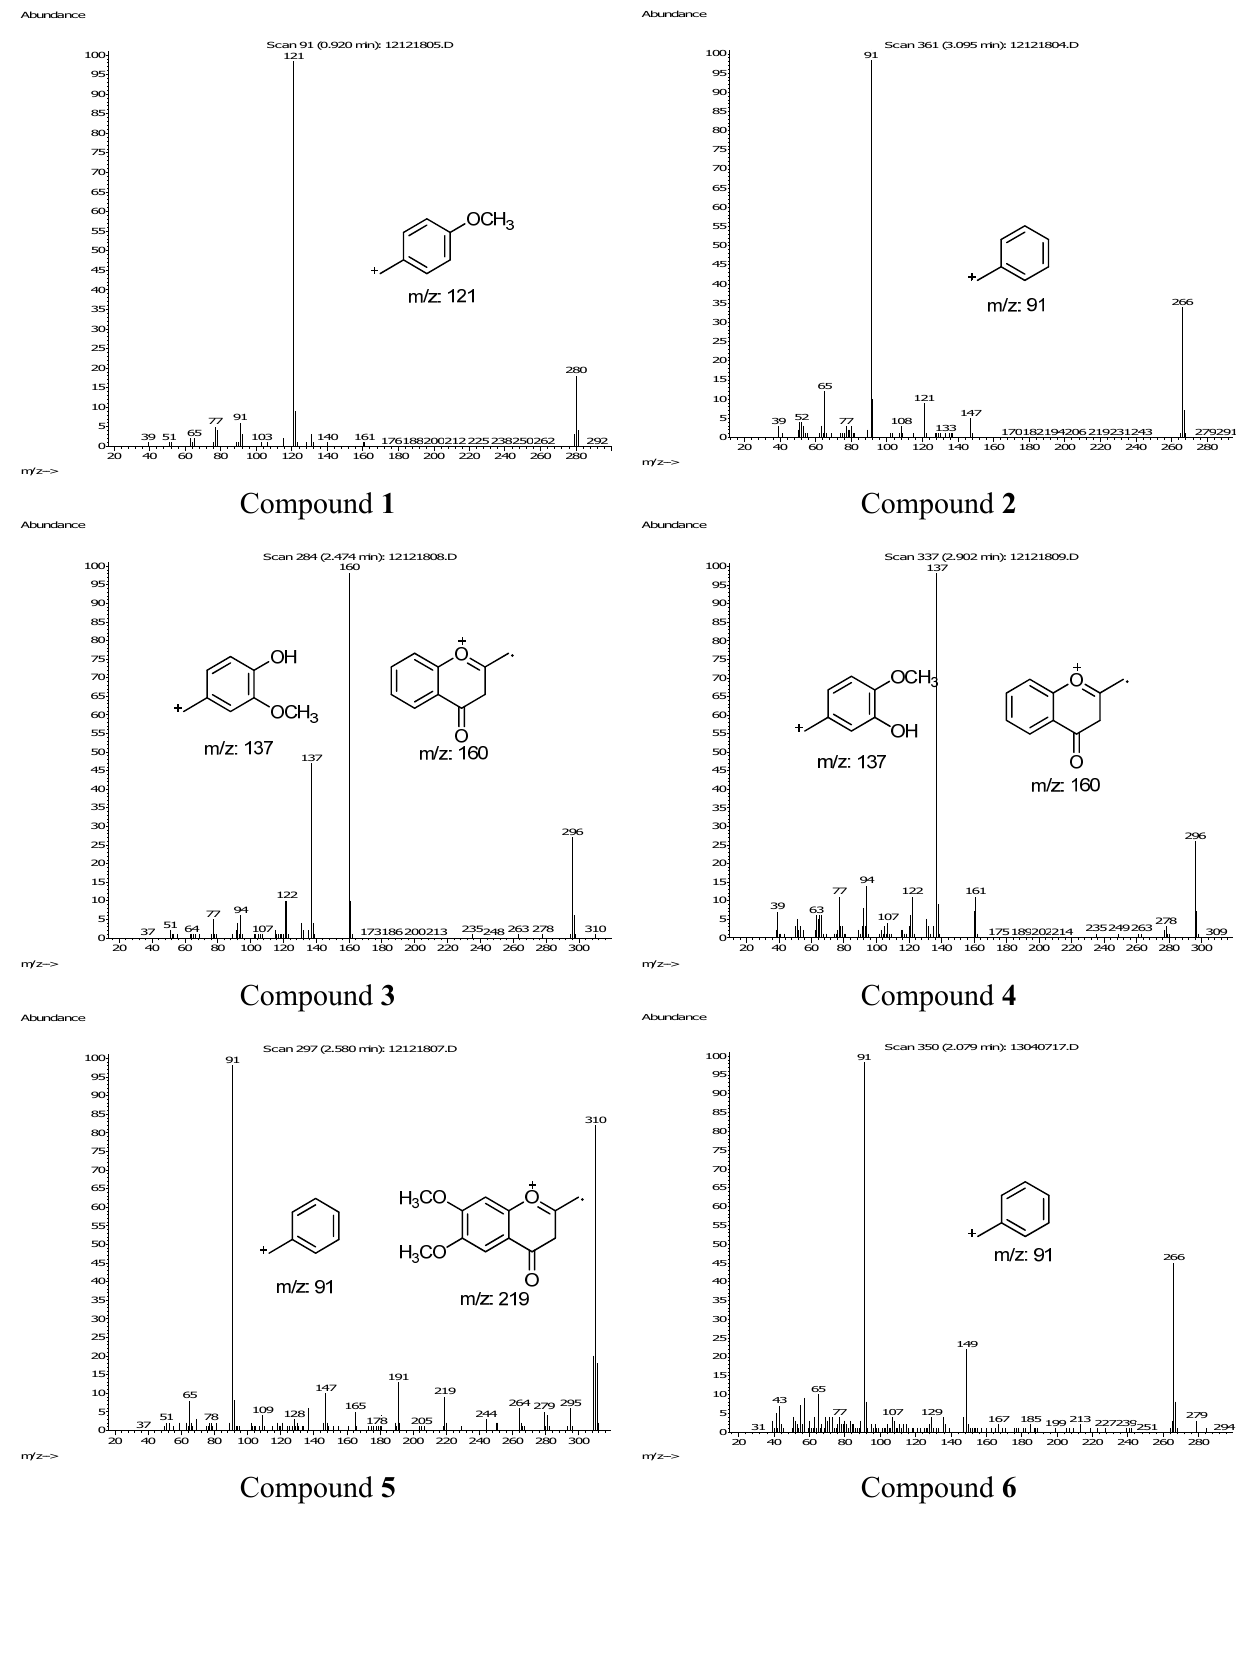
Figure 1. MS spectra of compounds 1 – 18 and the structures of characteristic fragment